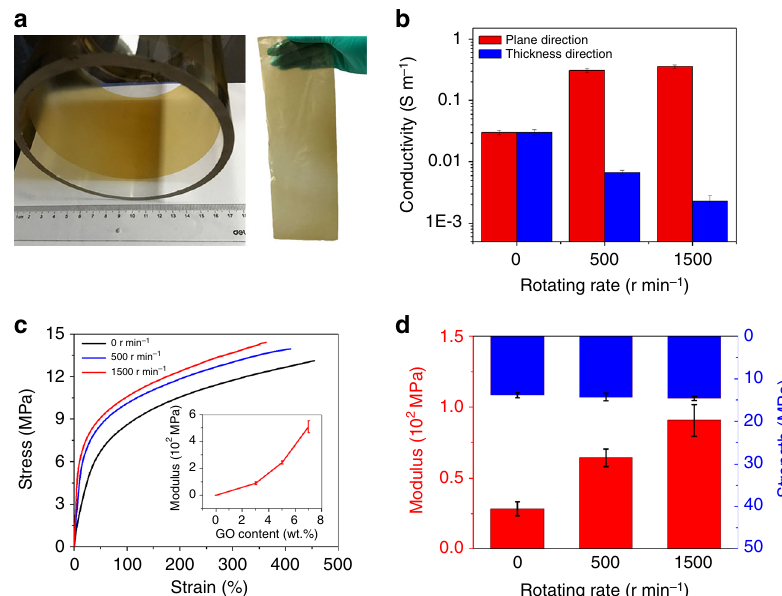
Fig. 6 Structure, electrical, and mechanical properties of highly anisotropic GO (rGO)/PU nanocomposites. a A uniform rGO/PU nanocomposite fi lm synthesized on the inner surface of RHT (left panel), which can be easily peeled off. A large rGO/PU fi lm with a thickness of ~100 μ m and size of 30 × 10 cm 2 (right panel). b Plane and thickness direction electrical conductivity of the rGO/PU nanocomposites fi lms synthesized at different rotating rate. c , d Typical stress-strain curves ( c ), and strength and modulus ( d ) of the GO/PU nanocomposites fi lms synthesized at different rotating rate. The content of rGO and GO nanosheets is 5 wt% and 3 wt% for the nanocomposites used for electrical conductivity and mechanical properties measurements, respectively. Inset of c , modulus of the GO fi lms synthesized with a rotating rate of 1500 r min – 1 as a function of GO